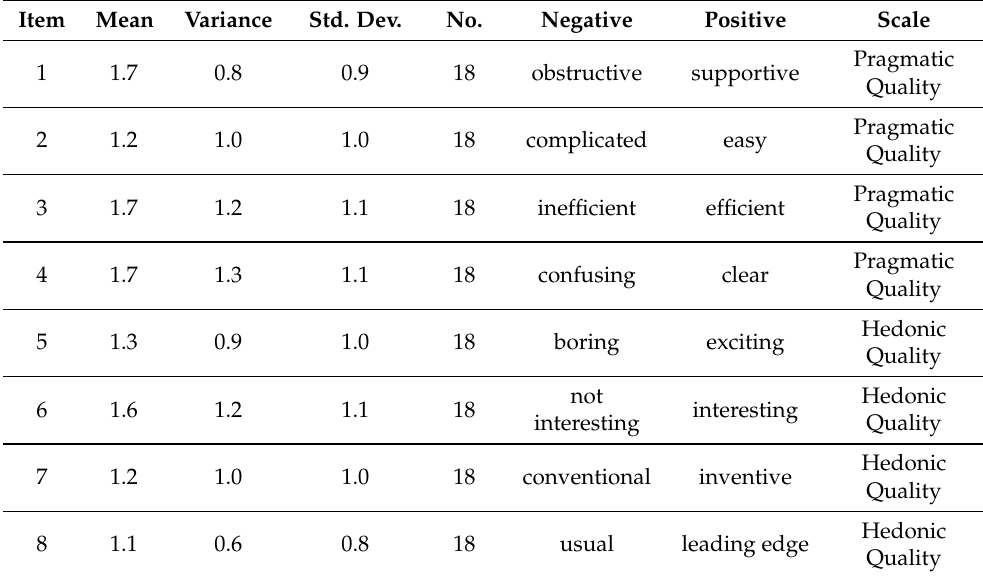
Table 2. UEQ short scale values for SAR